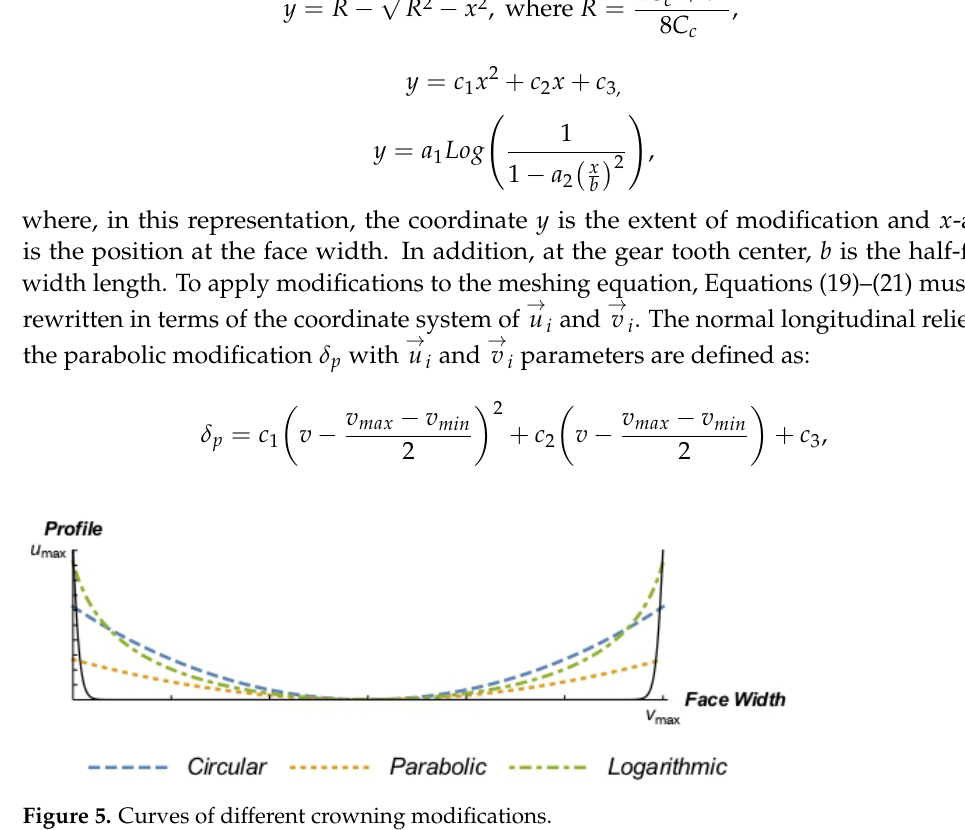
Figure 5. Curves of different crowning modifications.